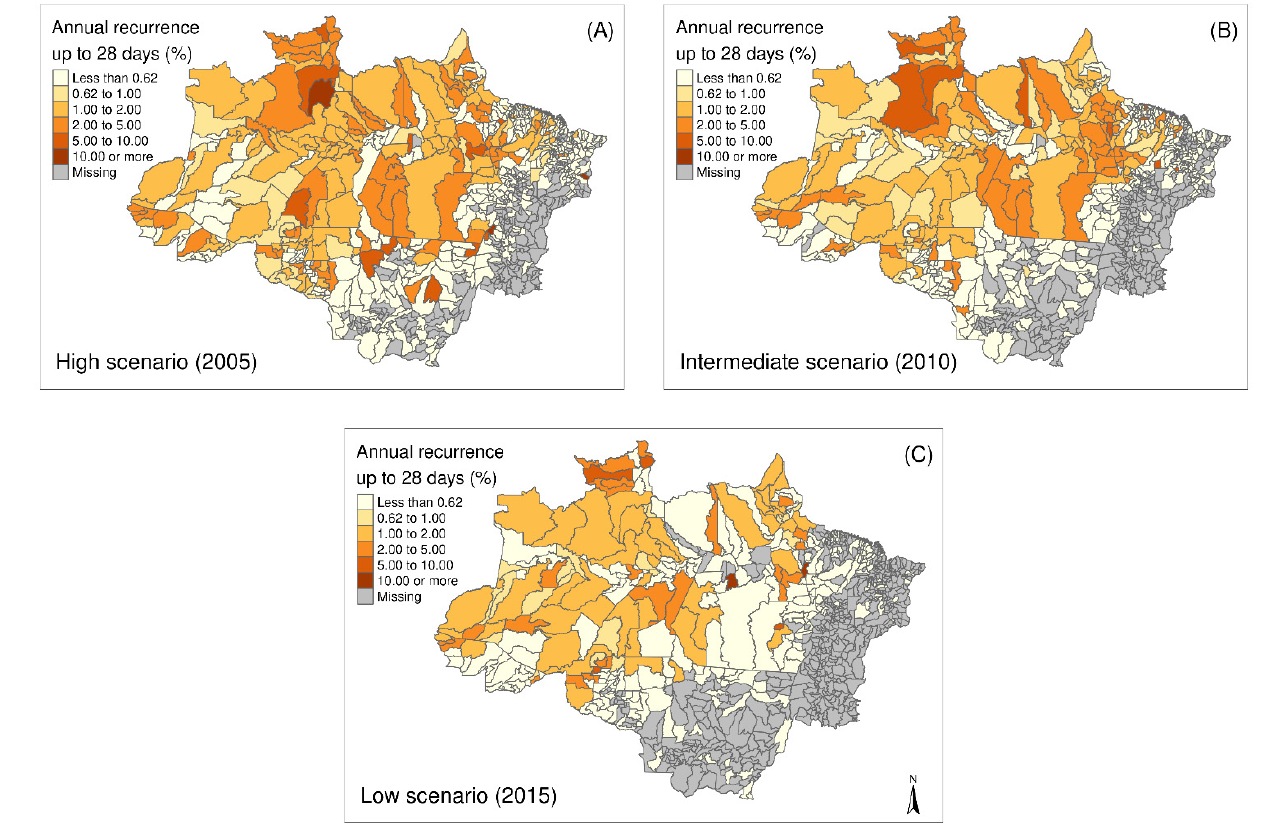
Figure 3. Spatial distribution of percentages of recurrence up to 28 days at the level of municipalities in the Brazilian Amazon in ( A ) 2005–High transmission scenario, ( B ) 2010–Intermediate transmission scenario, and ( C ) 2015–Low transmission scenario.